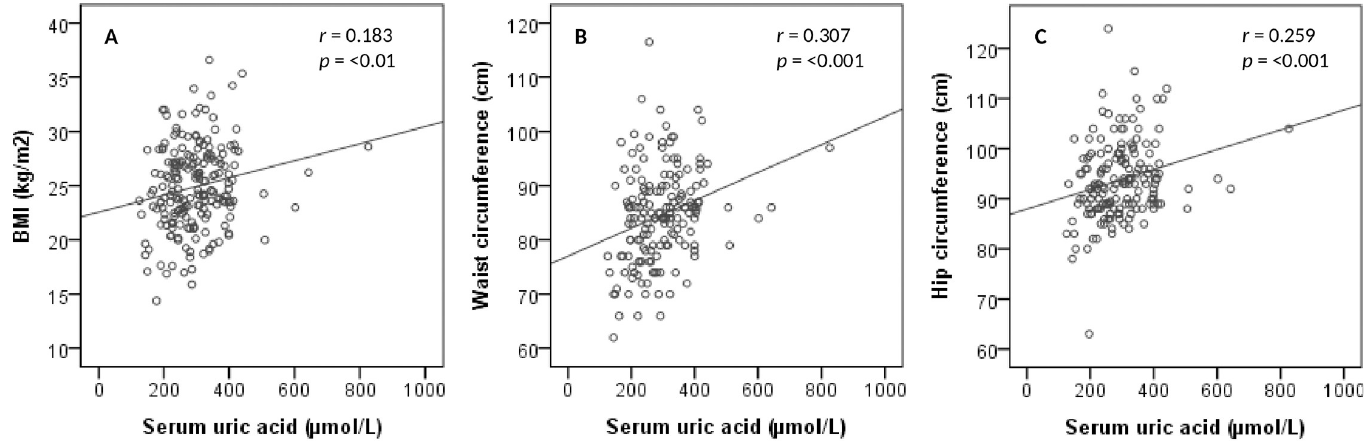
Fig 1. Correlation between serum uric acid with BMI (A), waist circumference (B) and hip circumference (C).